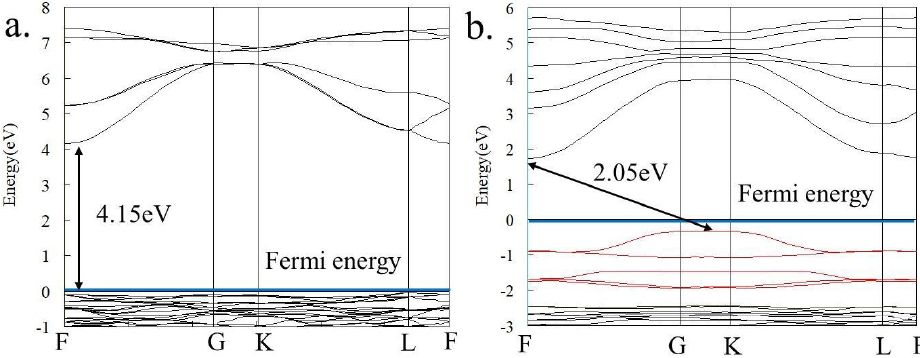
(a), ANS Catalyst (b). 3